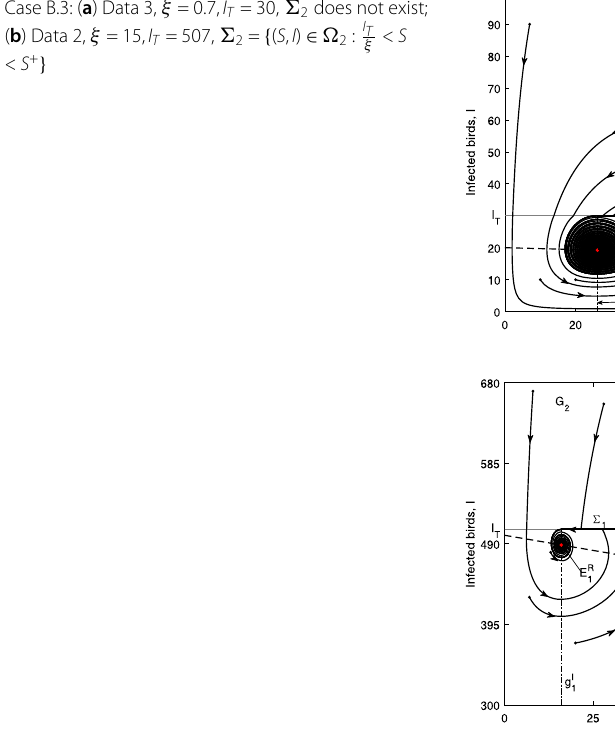
Figure 8 E R 1 is globally asymptotically stable in Case B.3: ( a ) Data 3, ξ = 0.7, I T = 30, (cid:5) 2 does not exist; ( b ) Data 2, ξ = 15, I T = 507, (cid:5) 2 = { ( S , I ) ∈ (cid:4) 2 : IT ξ < S < S +